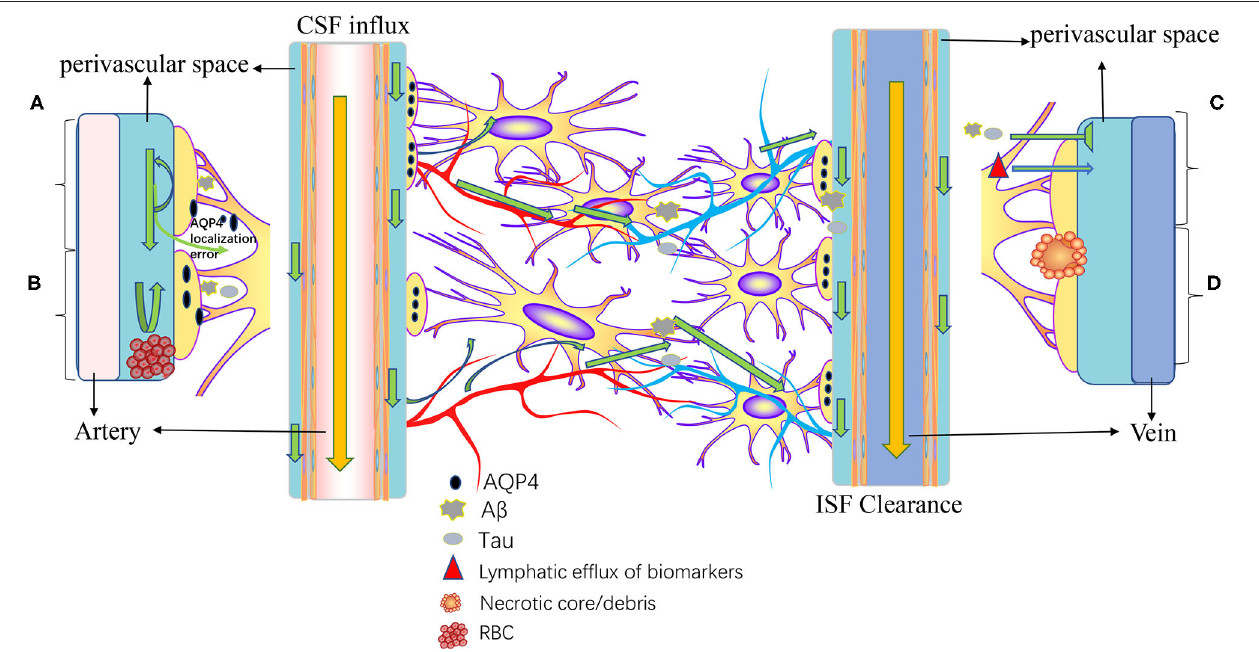
FIGURE 3 | Pathogenesis of diseases related to intracranial lymphatic circulation. A, Neurodegenerative diseases; B, cerebral hemorrhage; C, traumatic brain injury; and D, stroke and small vessel diseases. In neurodegenerative diseases, A β causes mislocalization of aquaporin-4 (AQP4) and impaired CSF influx and reduced CSF clearance. In intracranial hemorrhage, infiltration of blood components into the perivascular space, particularly fibrin/fibrinogen deposition, occludes the perivascular space, resulting in decreased CSF inflow. Traumatic brain injury results in decreased lymphatic clearance and biomarkers of injured parenchyma can be transported to the cervical lymphatic system via intracranial lymphatic pathways. In ischemic stroke and small vessel disease, a necrotic core forms within the brain parenchyma, and the contents of the necrotic core leak into the perivascular space through permeable glial scarring. Cerebral microinfarction can lead to transient decreased lymphatic inflow and prolonged retention of solutes within the infarcted core.